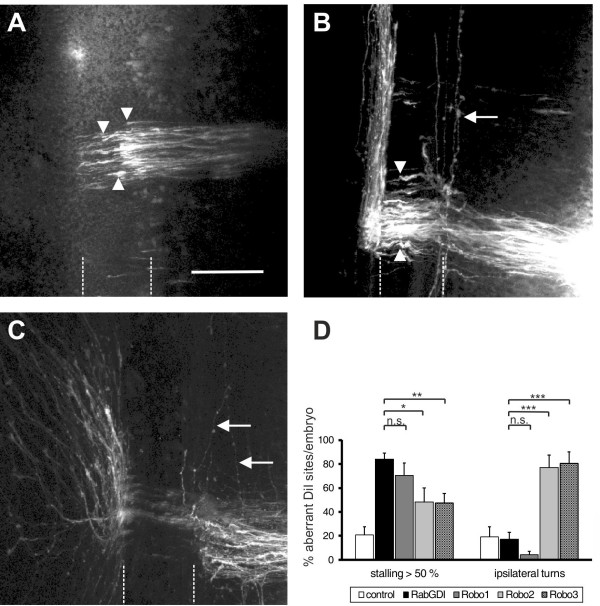
Loss of Robo1 function closely mimics the RabGDI phenotype. In ovo RNAi with dsRNA derived from Robo1 (A), Robo2 (B), and Robo3 (C) was used to silence these genes and compare their effect on commissural axon guidance at the midline. In the absence of Robo1, commissural axons stalled in the floor plate (dashed lines) and failed to reach the contralateral floor-plate border, as seen after loss of RabGDI function (arrowheads in A, compare to Figure 1C and D). Silencing Robo2 resulted in a distinct phenotype (B). While axons still stalled in the floor plate following loss of Robo2 (arrowheads in B), many injection sites additionally showed axons with abnormal ipsilateral turns (arrow in B, and D). Similarly, loss of Robo3 function resulted in ipsilateral turns (arrows in C). In contrast to the phenotypes seen after downregulation of Robo1 and Robo2, postcommissural axons were strongly defasciculated in the absence of Robo3 and many failed to grow along the contralateral floor-plate border. Phenotype quantifications are shown in (D). Significance levels: n.s. not significant, * p<0.05, ** p<0.01, *** p<0.001. Bar: 50 μm.